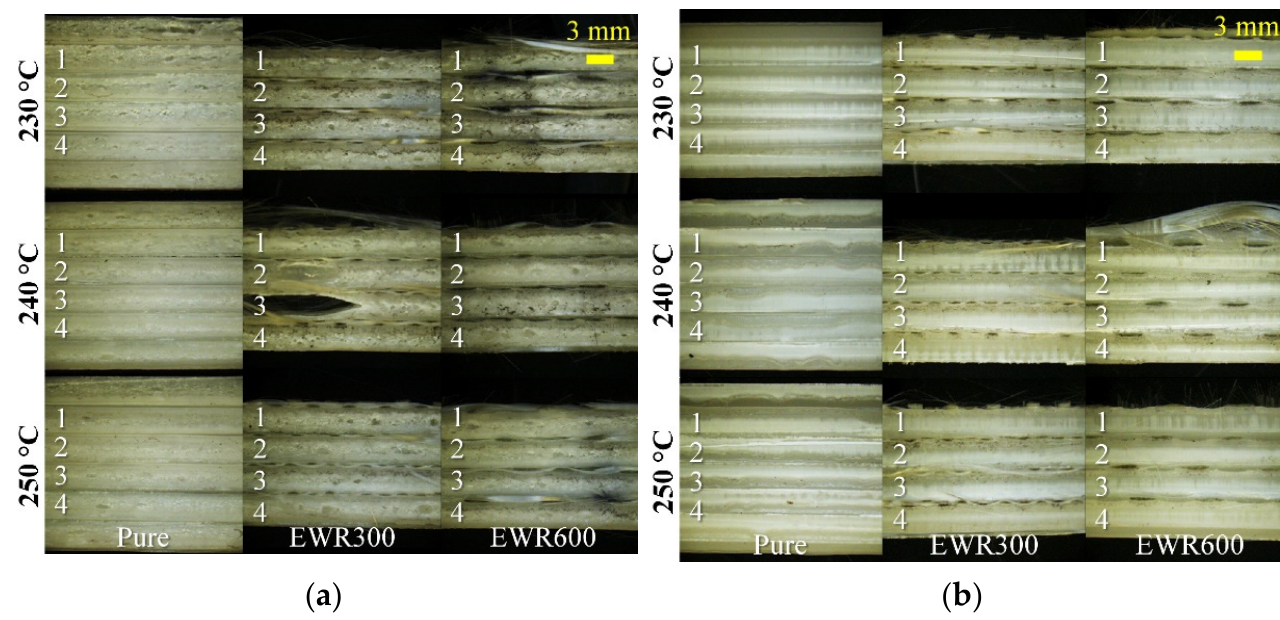
Figure 6. Pictures of the cut thick sections of the foamed tensile samples ( a ) and unfoamed tensile samples ( b ). The numbers of 1, 2, 3, and 4 indicate the number for each type of samples.